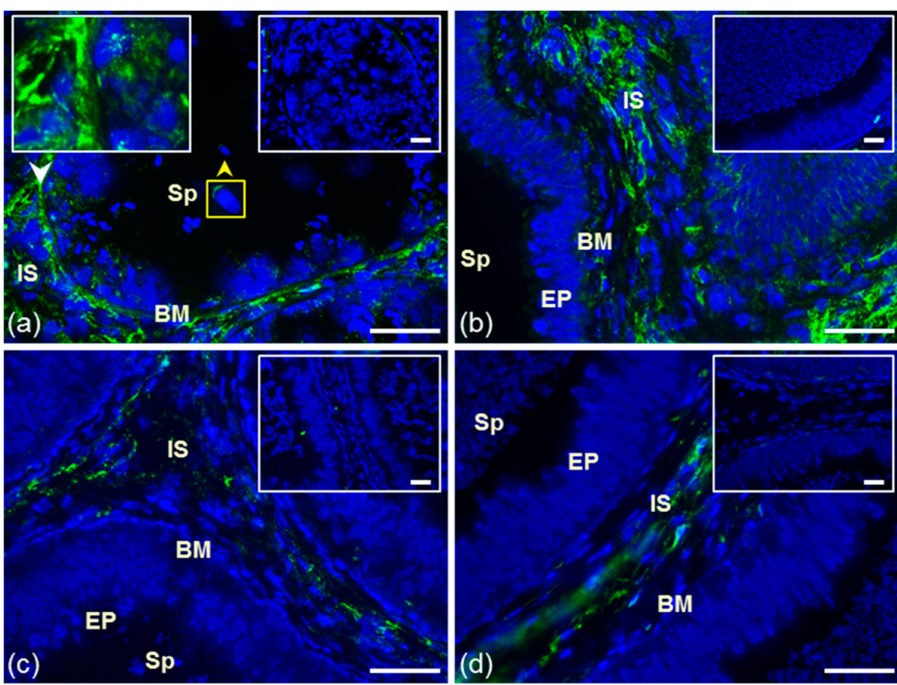
Figure 1. Reaction of anti-ESR2 antibody MA1-23221. Cryo-sections of bull reproduction tissues: testes ( a ) and epididymis: caput ( b ), corpus ( c ), and cauda ( d ). Tissues were treated with antibody MA1-23221 (green) or mouse IgG2 isotype control. Nuclear DNA was stained by DAPI (blue). Sp, spermatozoa; IS, interstitial tissue; BM, basal membrane; EP, epithelial cells. Controls are displayed in the top right corner of the figures. The white arrow points to the place depicted in the left frame, and the yellow arrow shows ESR2 localization in testicular sperm ( a ). Scale bar represents 50 µ m. Polyclonal K-19 and H-300 antibodies were used to detect the presence and distribution of GPER1 in cryo-sections of bull testes and epididymis. In the testicular tissues, the K-19 antibody did not react (Figure 2a). Signal of the K-19 antibody was observed in interstitial tissue (IS) of all epididymal parts and in the membrane of secretory epithelial cells (EP) in the caput and cauda epididymal tubule (Figure 2b–d). The reaction with polyclonal antibody H-300 in bull reproductive tissues was negative (Figure